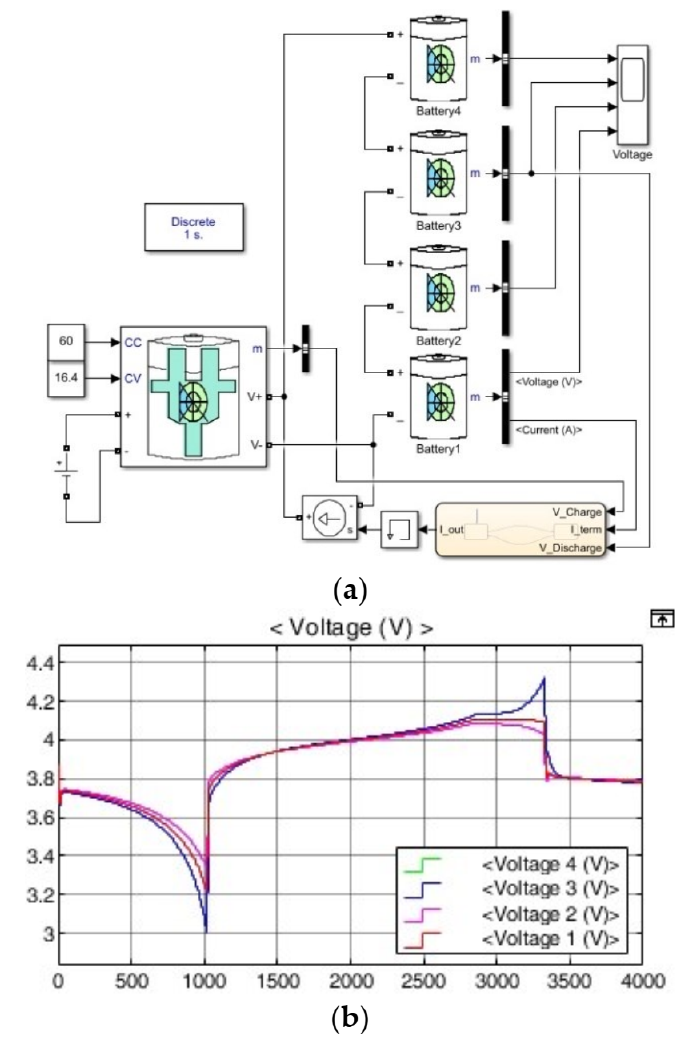
Figure 6. Charging/discharging simulations of series-connected batteries. ( a ) Schematic. ( b ) Voltage